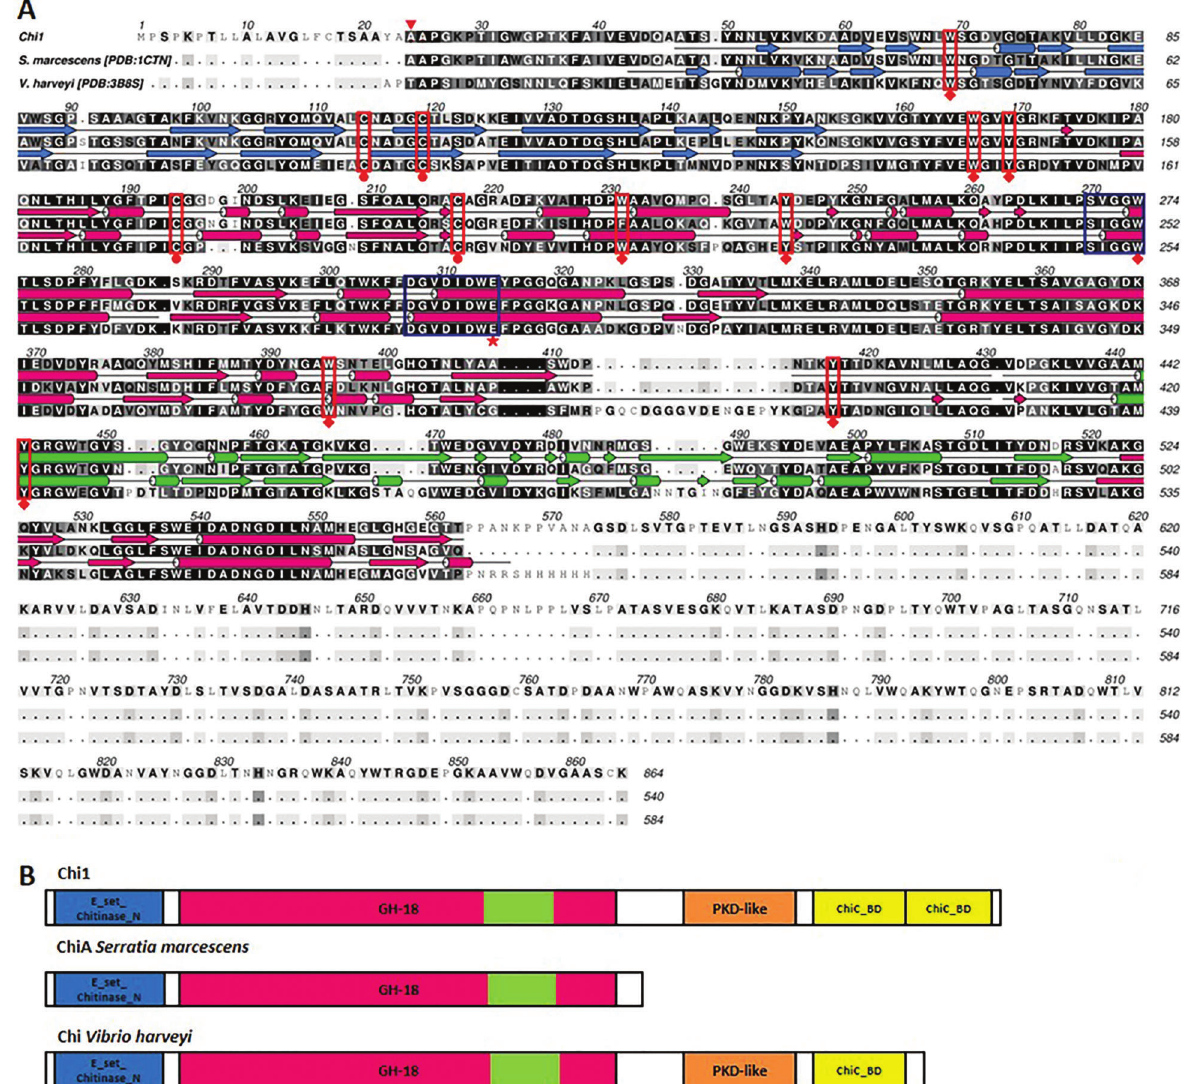
Figure 2. Amino acid sequence alignment, secondary structure estimation and domains schematic representation of MetaChi18A and most similar available chitinases structures. A , The triangle (pointing down) indicates the cleavage site of the signal peptide, diamonds indicate the conserved aromatic residues binding the substrate, circles indicate disul fi de bonds and the star indicates the glutamate residue involved in the hydrolysis. Dark blue boxes indicate the conserved sequences in the catalytic domain from glycosyl hydrolases family 18. The sequence background is colored according to the convention ALSCRIPT Calcons. Representations of secondary structures are given above the sequences: arrows for b -strands and cylinders for a -helix. Light blue is the E_set_chitinase_N, N-terminal domain, pink is the catalytic domain, and green is the ( a + b ) insertion in catalytic domain. B , Domain representations follow the same colors with the addition of: orange – PKD (polycystic kidney disease)-like domain with Ig-like fold, which probably functions as a ligand- binding site in protein-protein or protein-carbohydrate interactions and yellow – ChiC_BD (chitin-binding domain related to ChiC of Streptomyces griseus ). The N-terminal domain and the GH-18 catalytic domain from MetaChi18A [Genbank: KJ160494] have 74% identity with ChiA from Serratia marcescens [GenBank: ABI79317.1] and 54% identity with the chitinase from Vibrio harveyi [GenBank: